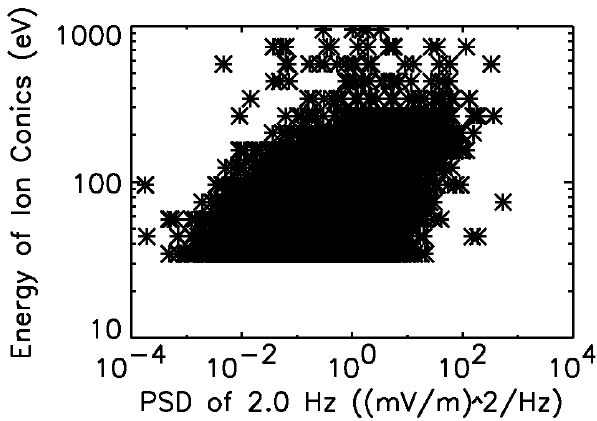
Fig. 1. Scatter plot of energy of ion conics and power spectral den- sity of 2.0-Hz component of